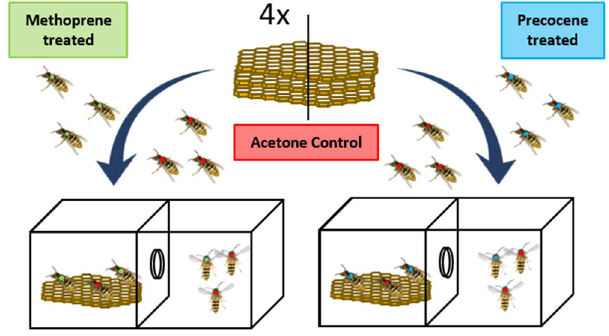
Figure 6. Scheme of the experimental setup. The combs of each of four natural colonies were divided into equal halves and put into separate boxes together with ca. 50 untreated workers. The abdomen of ca. 80 newly emerged workers per box and treatment was then topically treated once with 5 µ l of either 20 µ g/ µ l methoprene in acetone solution (green), 6 µ g/ µ l precocene-I in acetone solution (blue), or an acetone solvent control (red). After two weeks the workers were frozen at − 20 °C for later analysis of the